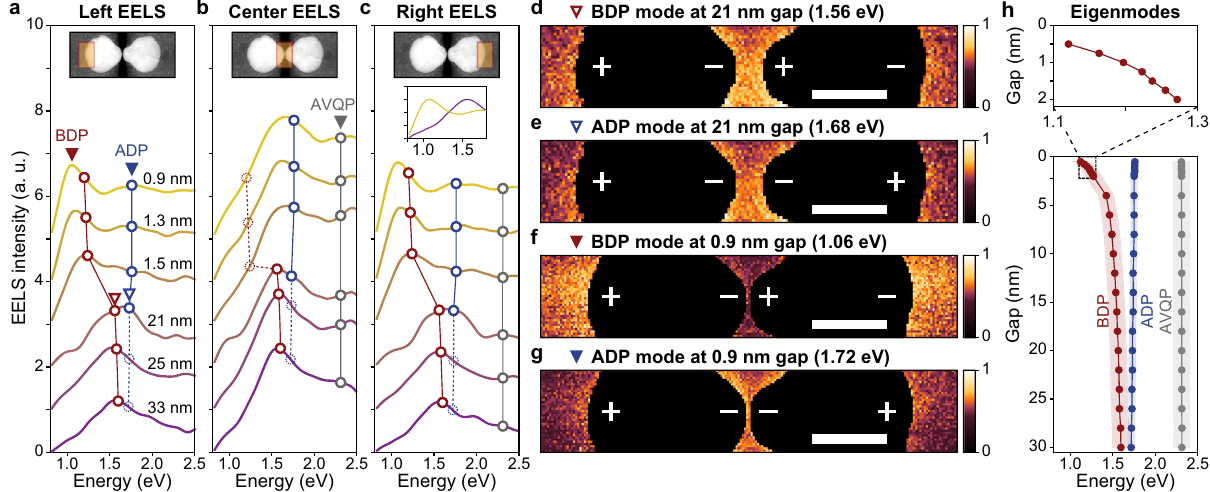
Fig. 2 Evolution of plasmon resonances from weak to strong coupling. a – c EELS spectra as a function of the gap size while scanning the electron beam over a rectangular region on the left ( a ), center ( b ), and right ( c ) part of the gold nanodisk dimer, as indicated by the orange-shaded regions in the inset STEM images. The inset spectra in Fig. 2c directly compare the EELS intensity for 33 nm and 0.9 nm gap sizes. Overlaid red, blue, and gray circles and trend lines indicate the peaks from numerically simulated eigenmode energies for the BDP, ADP, and AVQP modes, respectively (Fig. 2h). We offset each consecutive EELS intensity spectrum by equidistant, 1-step-values for improved visibility. d, e Spatial EELS maps of the BDP and ADP modes for a 21-nm- gap size. Scale bars: 50 nm. f, g Same EELS maps for a 0.9 nm gap size. Scale bars: 50 nm. h Evolution of the resonant photon energies of BDP, ADP, and AVQP modes as predicted by eigenmode solutions. The shaded regions indicate the linewidth for each mode. The inset highlights the region in which the BDP strongly red-shifts and the numerically calculated resonance sensitivity to the gap size for ~1